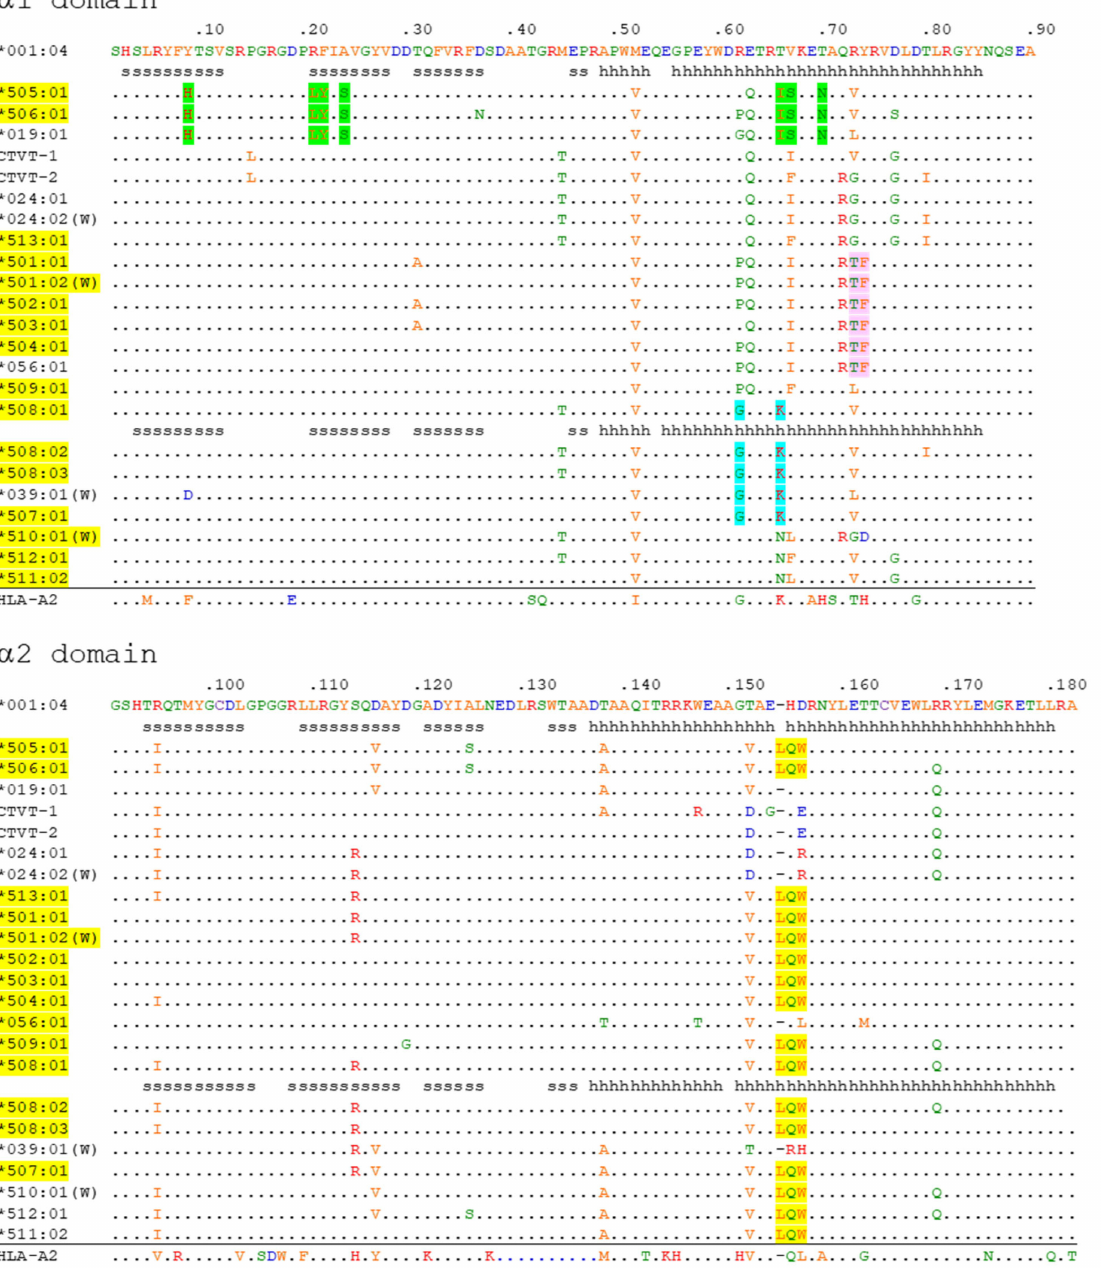
Figure 2. Alignment of deduced DLA-88 amino acid α 1 + α 2 domain sequences. Sequences repre- sentative for different branches of the DLA-88 phylogenetic tree (see Figure 1) and all known alleles of the DLA-88*5 category (yellow) are compared together with human HLA-A2. The DLA-88*5 category motif LQW is highlighted in yellow, and three other motifs are highlighted in green, pink, and cyan; the distribution pattern of LQW and the other highlighted motifs among the alleles is indicative of past interallelic recombination events. W, (also in) wolf; periods, identical residues; hyphens, gaps introduced in the alignment; s and h, beta-strands and helices, respectively, according to PDB accession 7CJQ for DLA-88*001:04 and PDB 5F1I for DLA-88*508:01. For GenBank accession numbers of most DLA-88 alleles see the IPD-MHC database. Other GenBank accession numbers